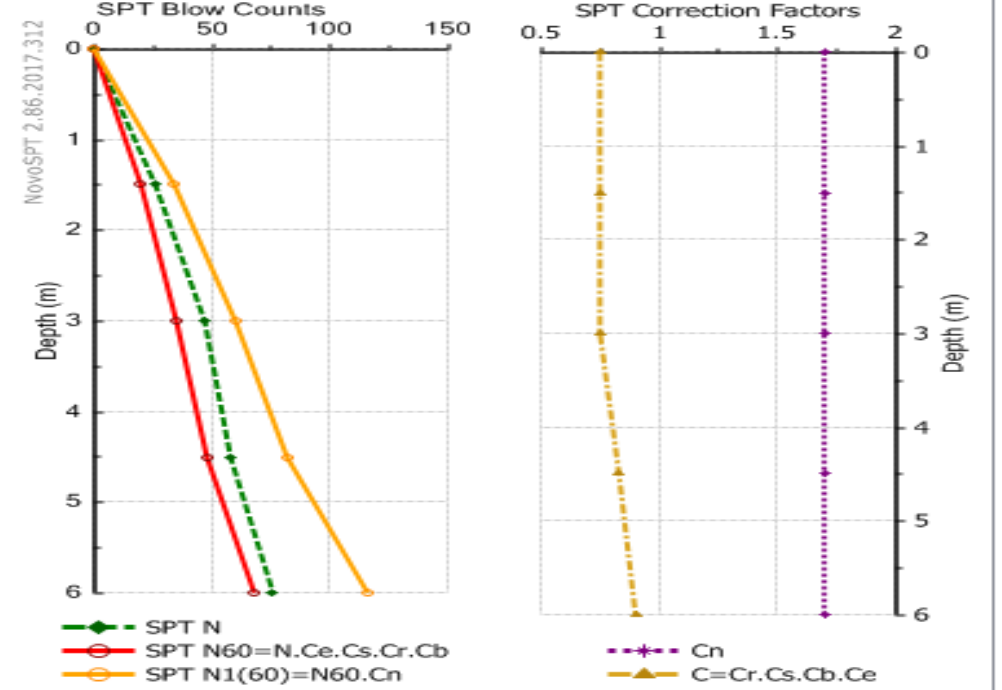
Fig. 2. Soil boring log layering and SPT results.